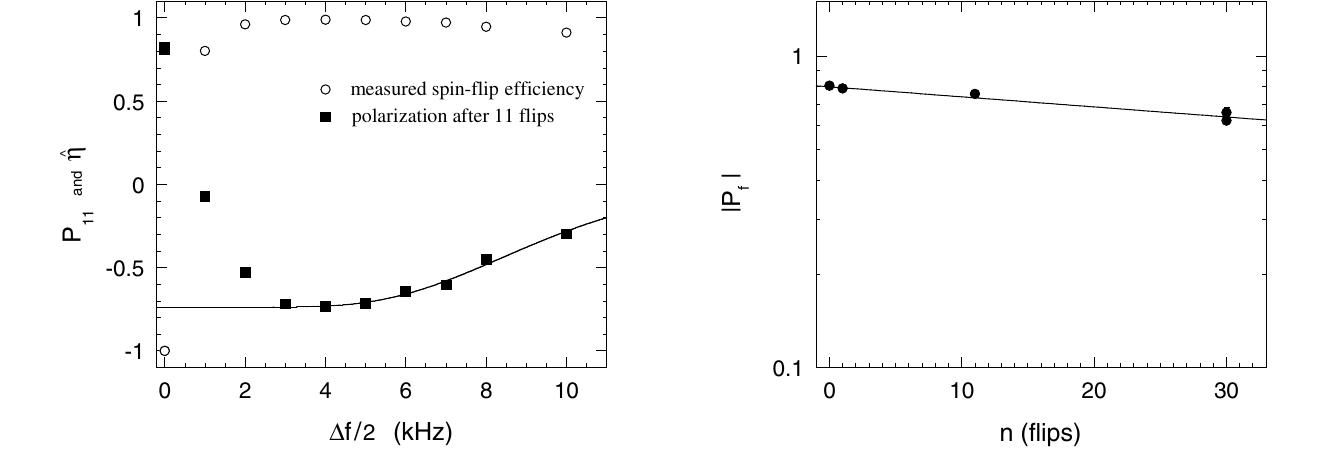
FIG. 4. The measured proton polarization at 1 : 941 GeV =c after 11 spin flips is plotted against the rf-dipole’s frequency half range (cid:15) f= 2 .The rf-dipole’s ramp time (cid:15) t was 7.5 s, and its R B dl was 0.11 T mm. The curve is a fit to Eq. (8). Also rms shown is the measured spin-flip efficiency ^ (cid:25)(cid:25) for each (cid:15) f obtained using Eq. (7) to take the 11th root of the measured =P . ratio (cid:4) P i 11